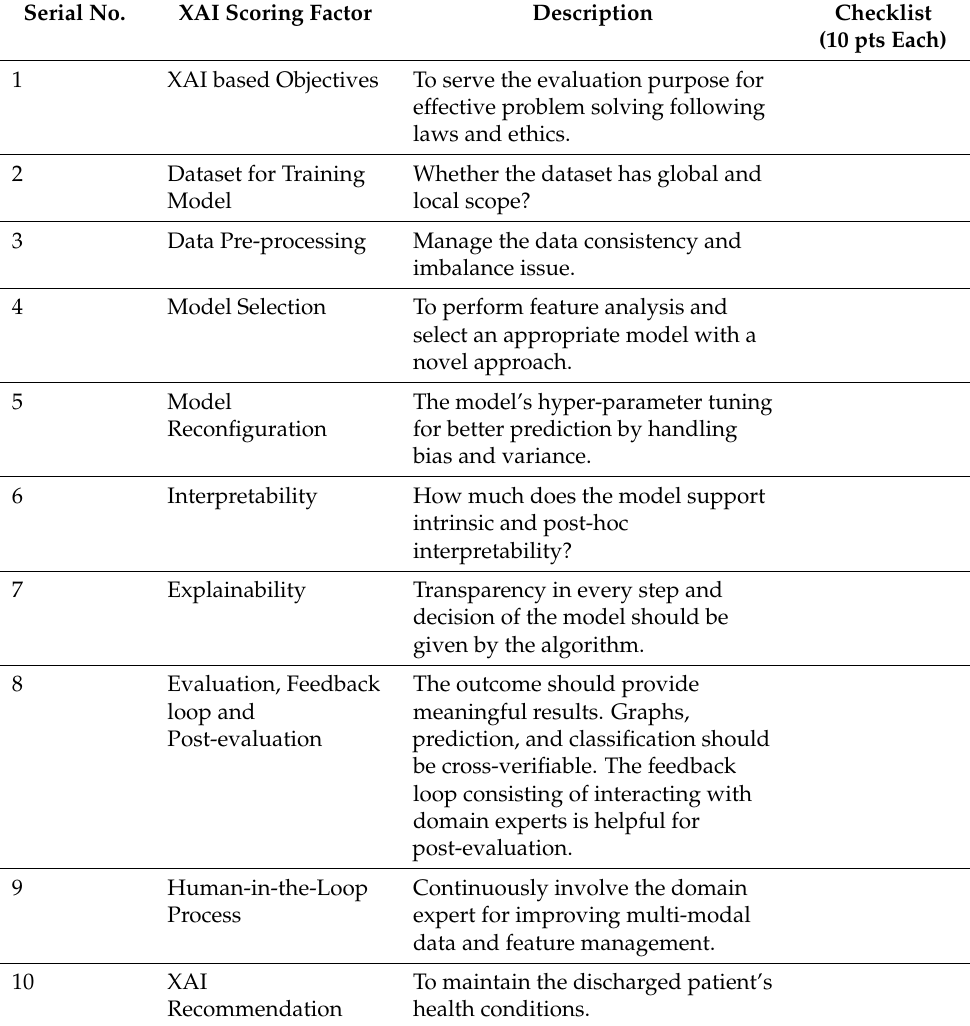
Table 9. Checklist for XAI scoring system.